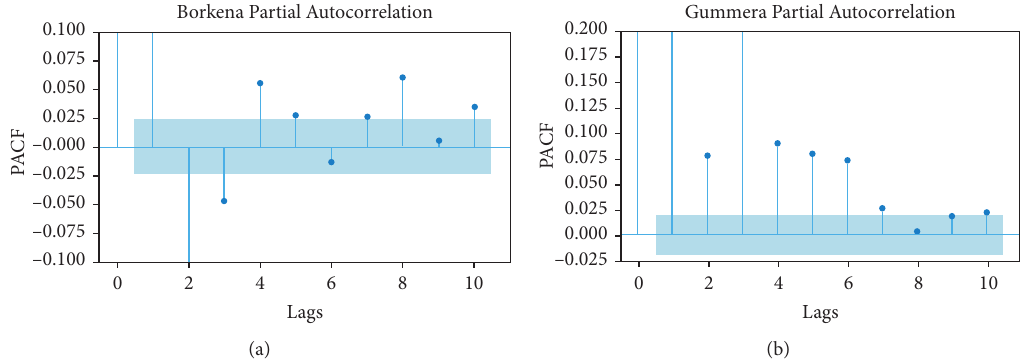
Figure 8: Partial autocorrelation of the daily time series for both catchments (lag units are in days, and the blue shadow lines indicate 95% confidence intervals). (a) Borkena, (b) Table 2: Keras tuner optimized hyperparameter values for Borkena station with its MSE score. MLP Hyperparameters